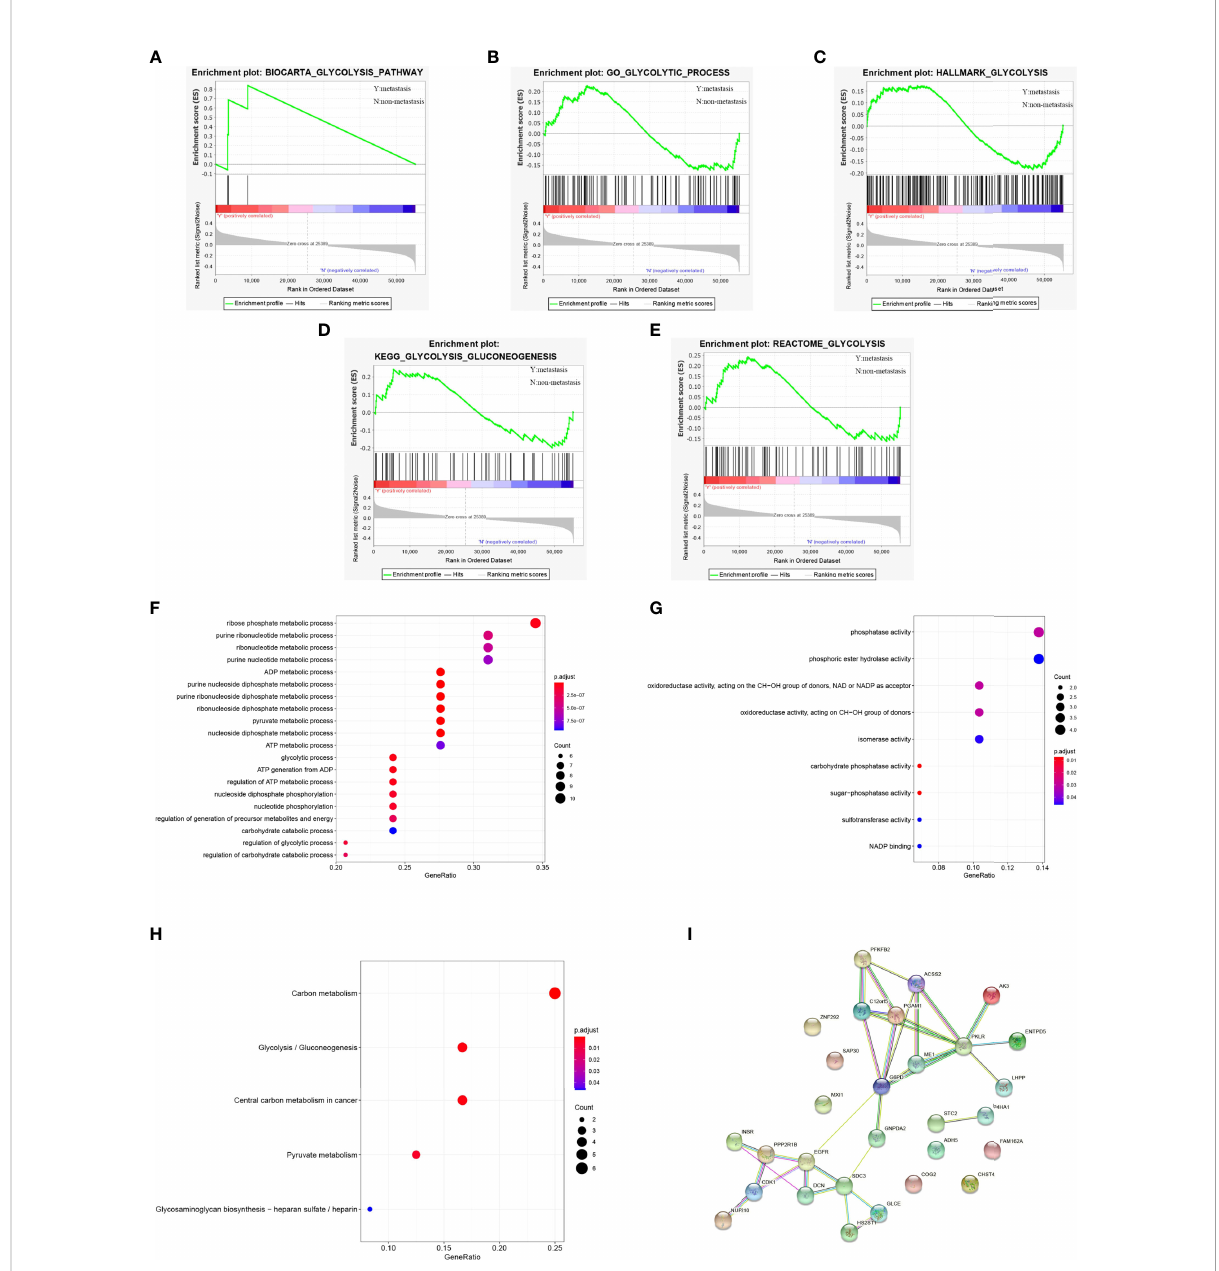
FIGURE 2 GSEA identi fi ed that fi ve glycolysis gene sets were signi fi cantly enriched. (A) BIOCARTA GLYCOLYSIS PATHWAY. (B) GO GLYCOLYTIC PROCES. (C) HALLMARK GLYCOLYSIS. (D) KEGG GLYCOLYSIS GLUCONEOGENESIS. (E) REACTOME GLYCOLYSIS. (F) GO-BP analysis of 29 survival- related genes. (G) GO-MF analysis of 29 survival-related genes. (H) KEGG analysis of 29 survival-related genes. (I) PPI network diagram of 29 survival-related